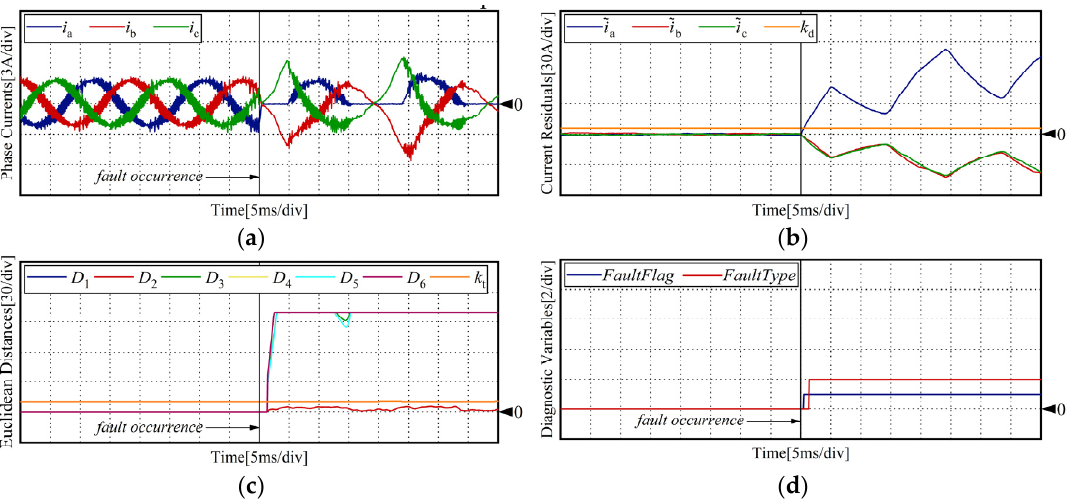
Figure 14. Test for a T 2 OC fault at a reference speed of 800 r / min: ( a ) phase currents; ( b ) current residuals; ( c ) Euclidean distances; ( d ) diagnostic variables.